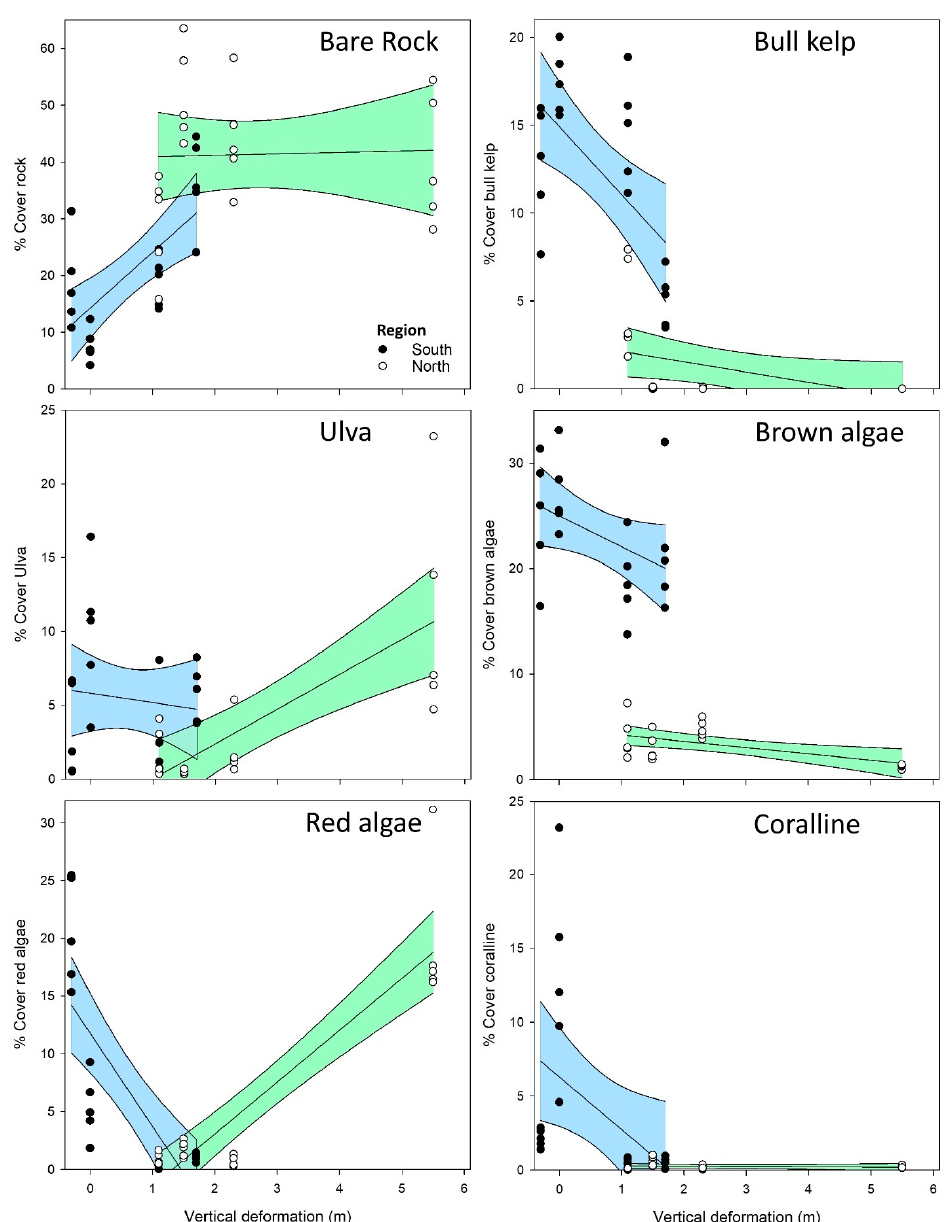
Figure 3. Percentage cover of several key habitat types at sites recovering from uplift. Locations are separated into two distinct biogeographic regions, “North” and “South” (see Table 1) and all the imagery was captured in February and March 2019. Linear regressions and 95% confidence intervals (CI) are shown for the two regions, North (green CI), and South (blue CI).